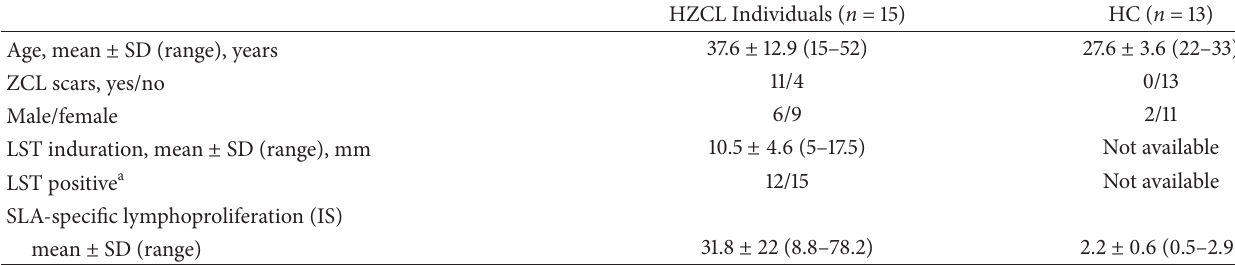
Table 1: Clinical and immunological features of the study